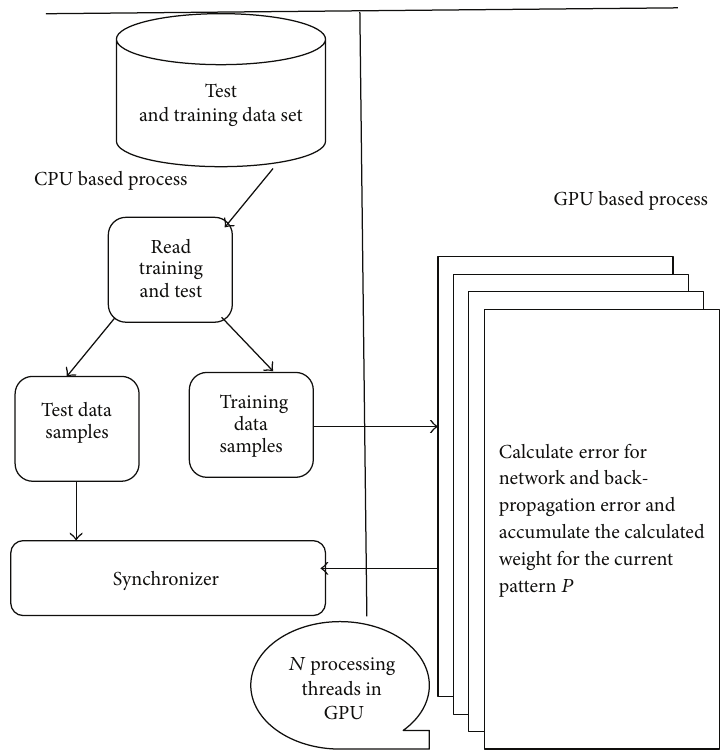
Figure 5: Hybrid architectural designs for training.